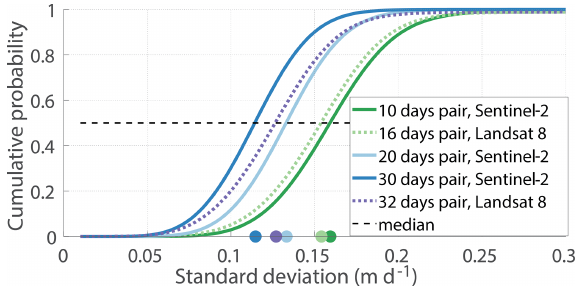
Figure 2. Cumulative distribution of the standard deviation of ve- locity in ice-free areas as a function of repeat cycle length for Sentinel-2 and Landsat 8 data. Colored points show the median value of the distribution for each repeat cycle, which represents the nominal precision achieved for each